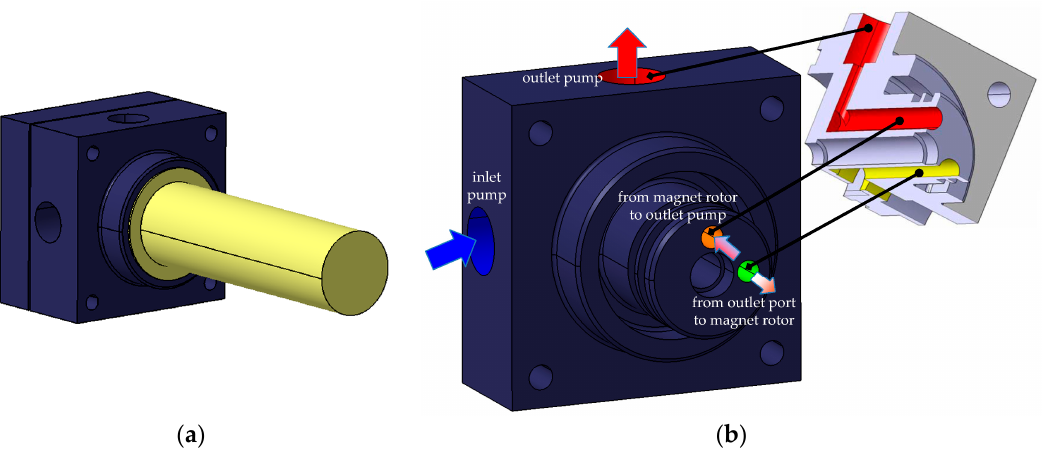
Figure 6. ( a ) Sealing of the magnet rotor by means of the sleeve, in yellow; ( b ) the ‘in-out sleeve